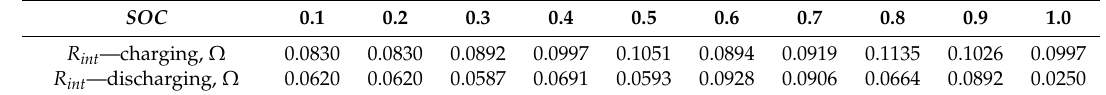
Table 3. Battery internal